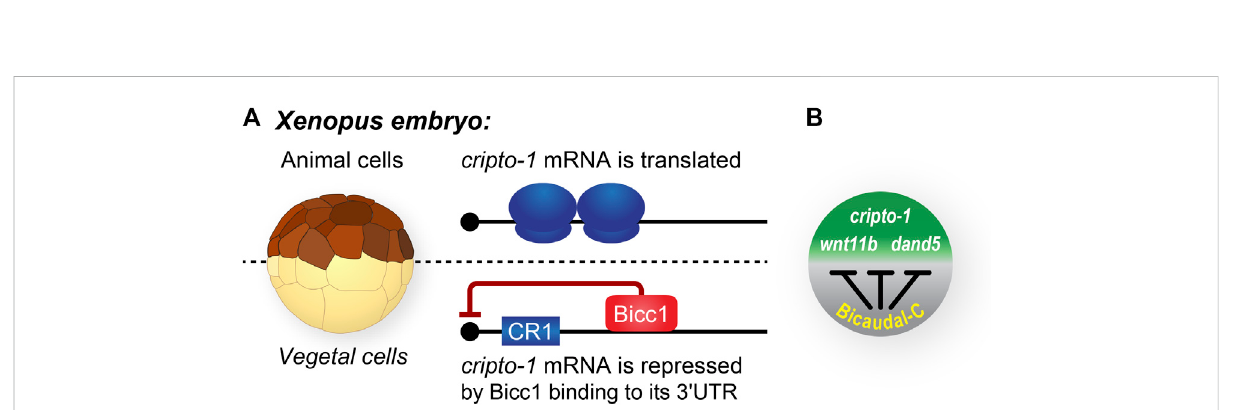
FIGURE 3 Bicaudal-C spatially regulates the accumulation of cell fate determinants in Xenopus embryos. (A) Xenopus blastula stage embryos are polarized with pigmented animal cells and non-pigmented vegetal cells. In general, mRNAs encoding cell fate determinants, such as cripto-1 are uniformly distributed throughout the embryo. In contrast, the Bicc1 repressor protein is present in a vegetal to animal gradient in which the highest concentrationofproteinispresent inthevegetalcellsandthelowestintheanimalcells(Parketal.,2016). (B) Bicc1 targetmRNAsaretranslated into protein with different ef fi ciencies due to the their position in the Bicc1 repression gradient (Sheets et al., 2017).